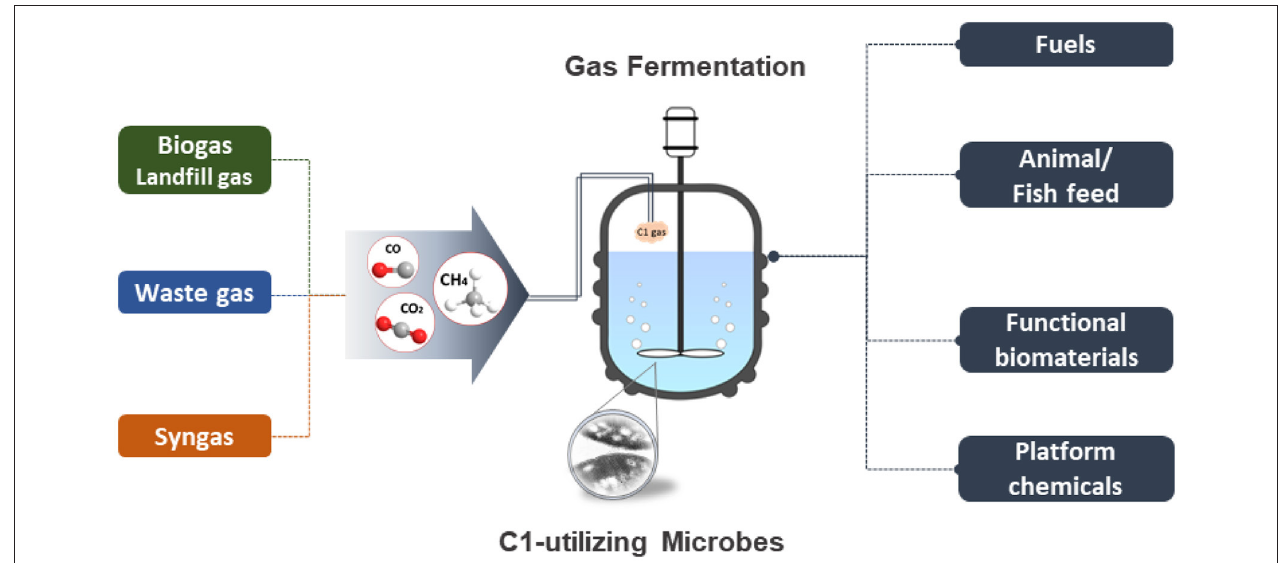
FIGURE 1 | Bioconversion and biorefinery of C1